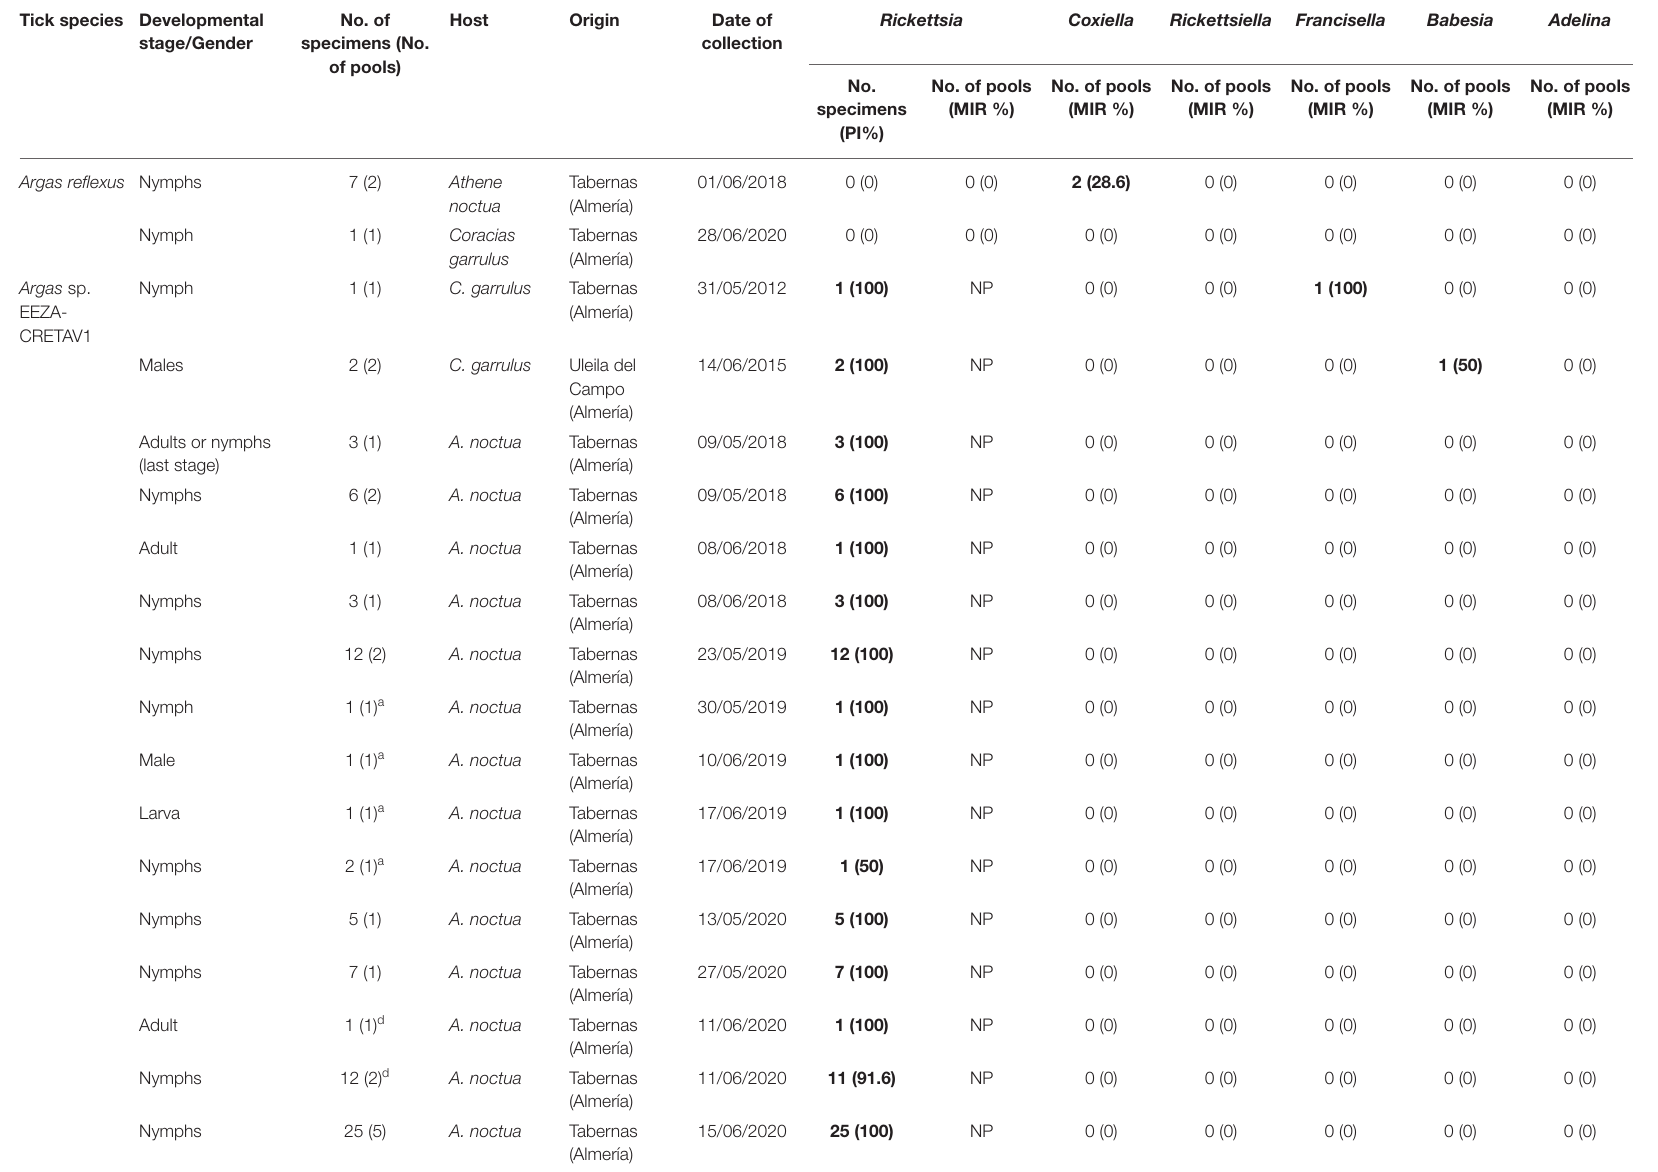
TABLE 3 | Microorganisms detected in this